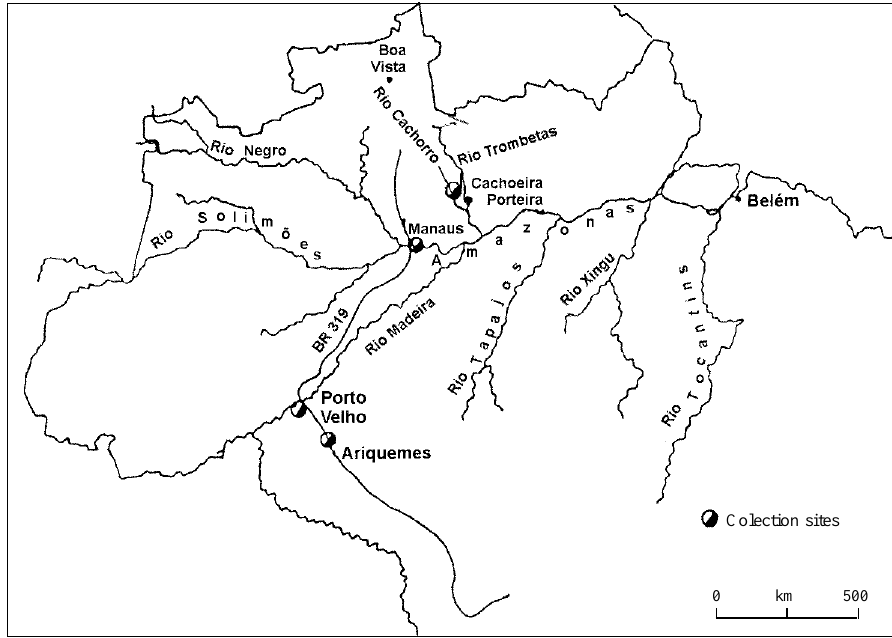
Figure 1 - Collection sites of Anopheles darlingi populations in the Amazon region.